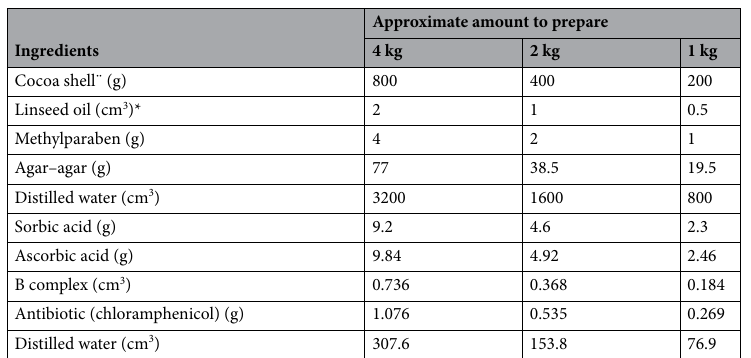
Table 1. Meridic diet for Carmenta theobromae proposed and used in this study. ¨: refers to the exocarp of the fruit of Theobroma cacao L. as the main ingredient. Values for the approximate amount of this ingredient to prepare, include the water that naturally comprises the exocarp. *It can be replaced by cholesterol or another fat source. Source : Pulido Blanco